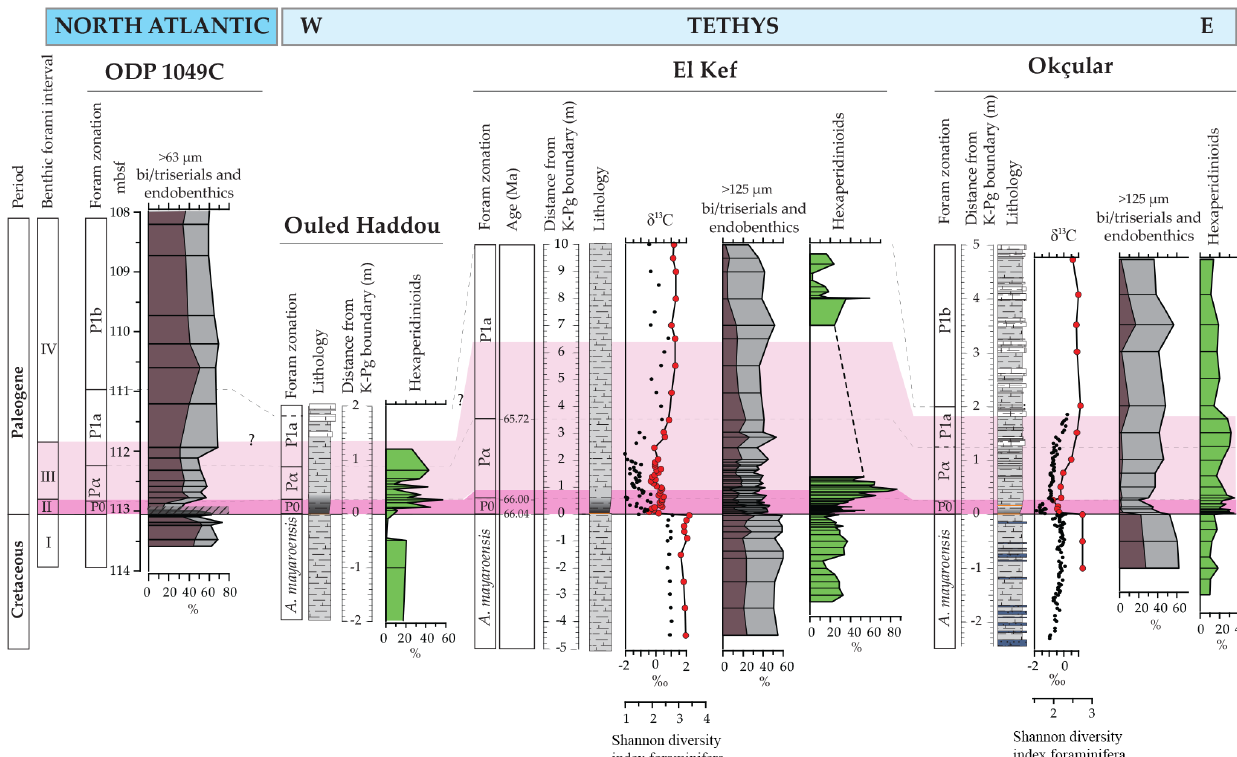
Figure 8. The benthic foraminiferal (>125µm) dinocyst and bulk stable carbon isotope records of Okçular (Turkey) and El Kef (Tunisia), the dinocyst record of Ouled Haddou (Morocco), and the benthic foraminiferal record (>63µm) of ODP Hole 1049C Blake Nose (North Atlantic). Note that the definition of “hexaperidinioids” used is provided in the text. The four phases identified based on the bulk stable carbon isotopes and the Shannon diversity index ( H ) of the benthic foraminiferal records are indicated (I–IV). The >63µm size fraction benthic foraminiferal record of ODP Hole 1049C is from Alegret and Thomas (2004), who argued that the lowermost Paleocene of this site comprised reworked foraminifera. This interval is indicated by a dashed bar in the figure. The biostratigraphy of Ouled Haddou is from Slimani and Toufiq (2013), whereas the dinocyst record of this site is from Slimani et al. (2010). The biostratigraphy of El Kef is based on Brinkhuis et al. (1998), Speijer and van der Zwaan (1996) and Molina et al. (2006). The fine-fraction stable carbon isotope record (black dots) of El Kef is from Keller and Lindinger (1989). The Shannon diversity index (red dots), relative abundances of bi-/triserial benthic taxa (dark purple), and all endobenthic foraminifera (light purple) are based on the >125µm size fraction foraminiferal data of Speijer and van der Zwaan (1996). The palynological data of El Kef are from Brinkhuis et al. (1998) (lower part) and Guasti et al. (2005) (upper part). The Shannon diversity index of the >125µm size fraction benthic foraminiferal record (red dots), the relative contribution of bi-/triserial benthic taxa (dark purple), all endobenthic foraminifera (light purple), and hexaperidinioid dinocysts from Okçular are from this study. The bulk stable carbon isotope record of Okçular (black dots) is from Açikalin et al. (2015). Mbsf indicates meters below sea